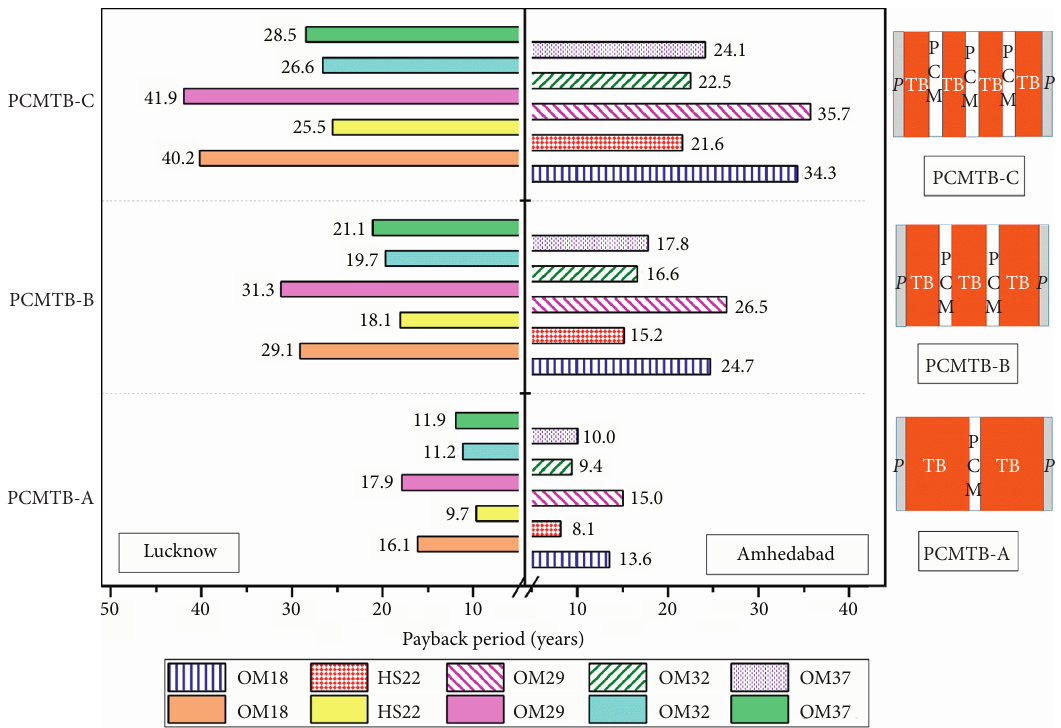
Figure 9: Payback periods of terracotta brick buildings integrated with PCMs in Ahmedabad and Lucknow.